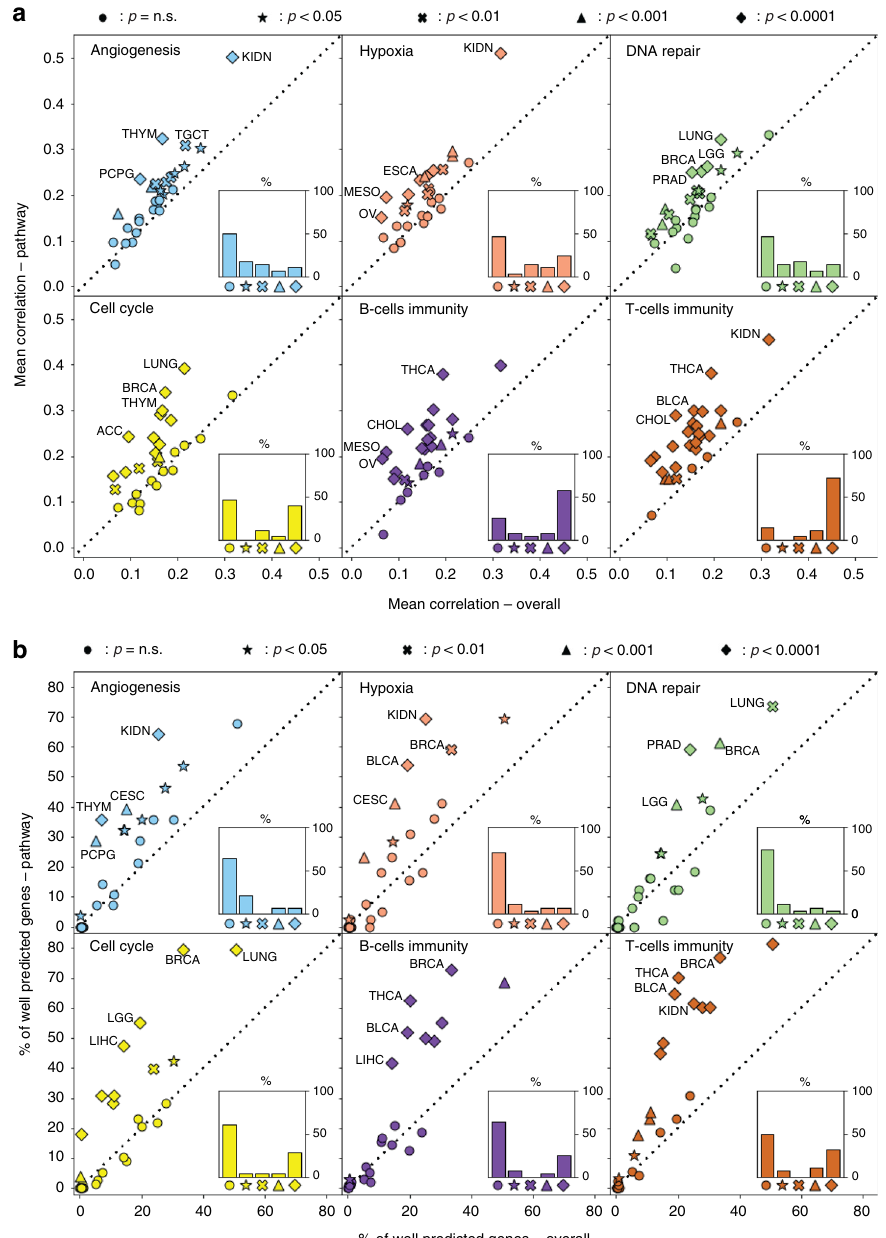
Fig. 3 Prediction of signatures for cancer hallmarks. a Comparison of correlation scores R p for each gene pathway de fi ned in Supplementary Table 4 and involved in angiogenesis, hypoxia, DNA repair, cell cycle, and immune responses mediated by B and T cells, with the mean correlation coef fi cient R 0 obtained for 10,000 random lists of the same number of genes, for all 28 cancer types from the TCGA dataset. The indicated statistical signi fi cance refers to the probability of obtaining a correlation R > R p in the distribution of correlations for random lists, for each given cancer type. Insets show the percentages (%) of the different cases of statistical signi fi cance between cancer types. The dashed line is the identity line R p = R 0 . b As in a , , but in terms of percentage of genes considered well-predicted (as de fi ned in the text and in Fig. 2). One-sided empirical p -values computed as described in “ Methods ” (circle: p = ns, star: p < 0.05, cross: p < 0.01, triangle: p < 0.001, square: p <